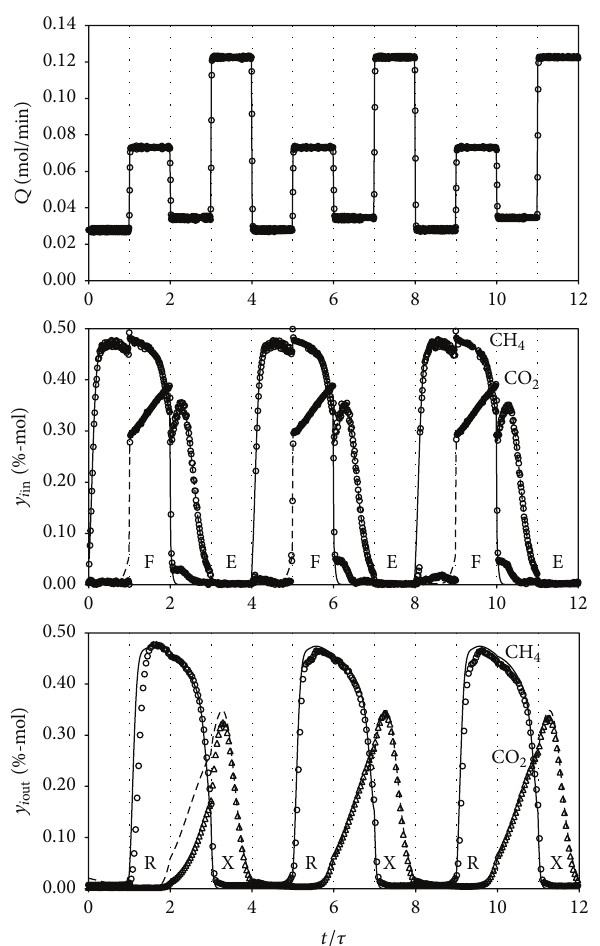
Figure 7: Experimental (symbols) and simulated (lines) temporal profiles of total molar flow rate ( 𝑄 ), inlet composition ( 𝑦 𝑖 in ), and outlet composition ( 𝑦 𝑖 out ) of the gas flowing through a column for the 3 cycles of a classical 4-column SMB (synchronous) operation: CH 4 /CO 2 in N 2 , 309 K, and 4bar. Every cycle, fresh feed, and eluent are added during 1 < 𝑡/𝜏 < 2 and 3 < 𝑡/𝜏 < 4 , respectively; extract is obtained at 1 < 𝑡/𝜏 < 2 and raffinate is withdrawn at 3 < 𝑡/𝜏 < 4 . The optimized feed flow rate is 𝑄 F = 38.9 mmol/min for a specific eluent consumption of 𝑄 E /𝑄 F = 2.44 and a switching interval of the cycle of 𝜏 = 9.22 [5].